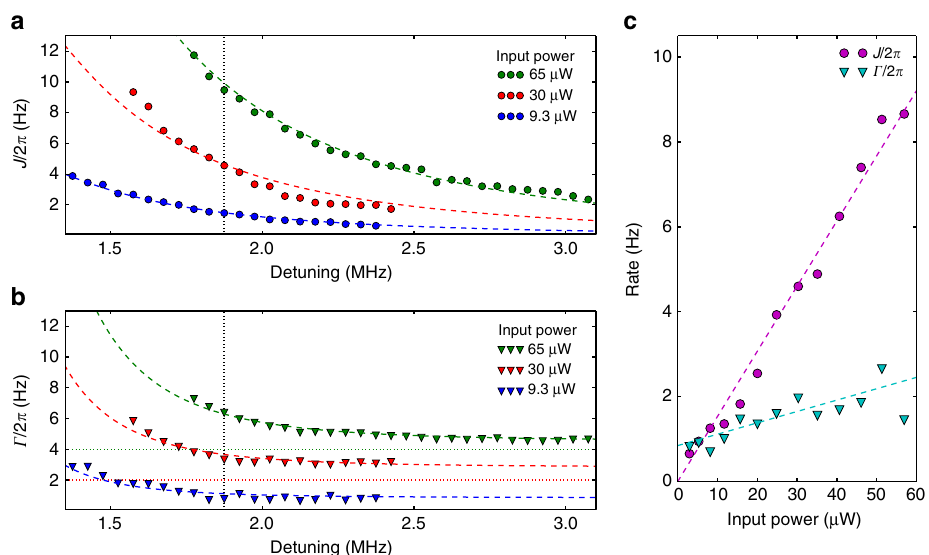
Fig. 4 Parameter dependence of optomechanical swapping rate and total loss rate. Optomechanical swapping rate, J a , and total loss rate, Γ b , are measured as a function of detuning ( Δ /2 π ). The dashed lines are two parameter fi ts based on Equations (2) and (3). For clarity the higher power measurements of Γ are vertically offset by 2 and 4 Hz as indicated by the dotted lines. c J and Γ are measured as a function of input power at a detuning of 1.87 MHz (indicated by black dotted line in a and b ). The dashed lines are two parameter fi ts based on Equations (2) and (3). The ratio between the measured optical power and the input power P in and the mean bare mechanical dissipation rate ( γ 1 + γ 2 )/2 are the fi tting parameters (Methods section). Statistical uncertainties are smaller than the point